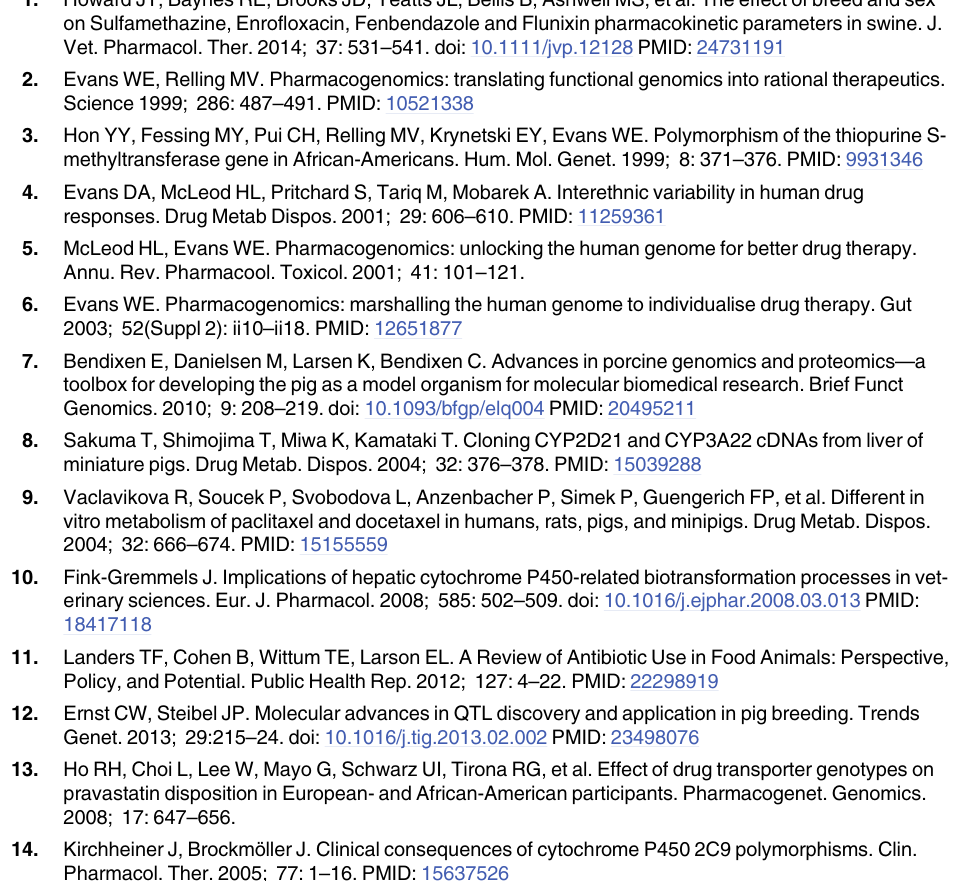
S4 Table. Breed and sex fold change (Significance 1 ) comparisons derived from animals administered Fenbendazole across target